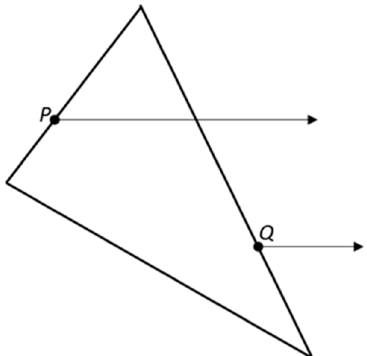
Figure 6. Points P on the ‘left’ edges of the polygon are classified as inside. Points Q on the ‘right’ edges of the polygon are classified as outside (redrawn according to [34]).